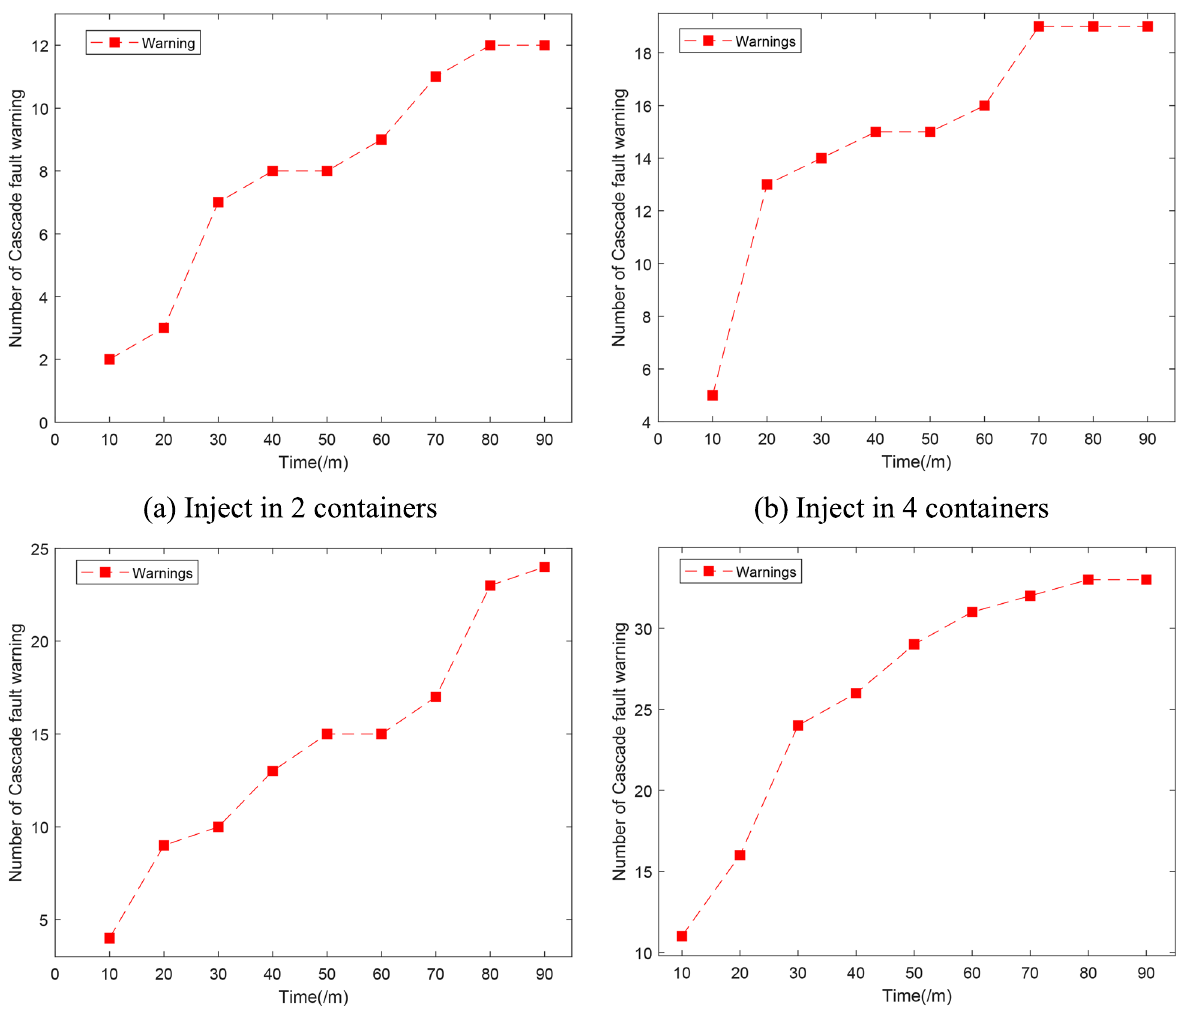
Fig. 16 Number of faults detected by the